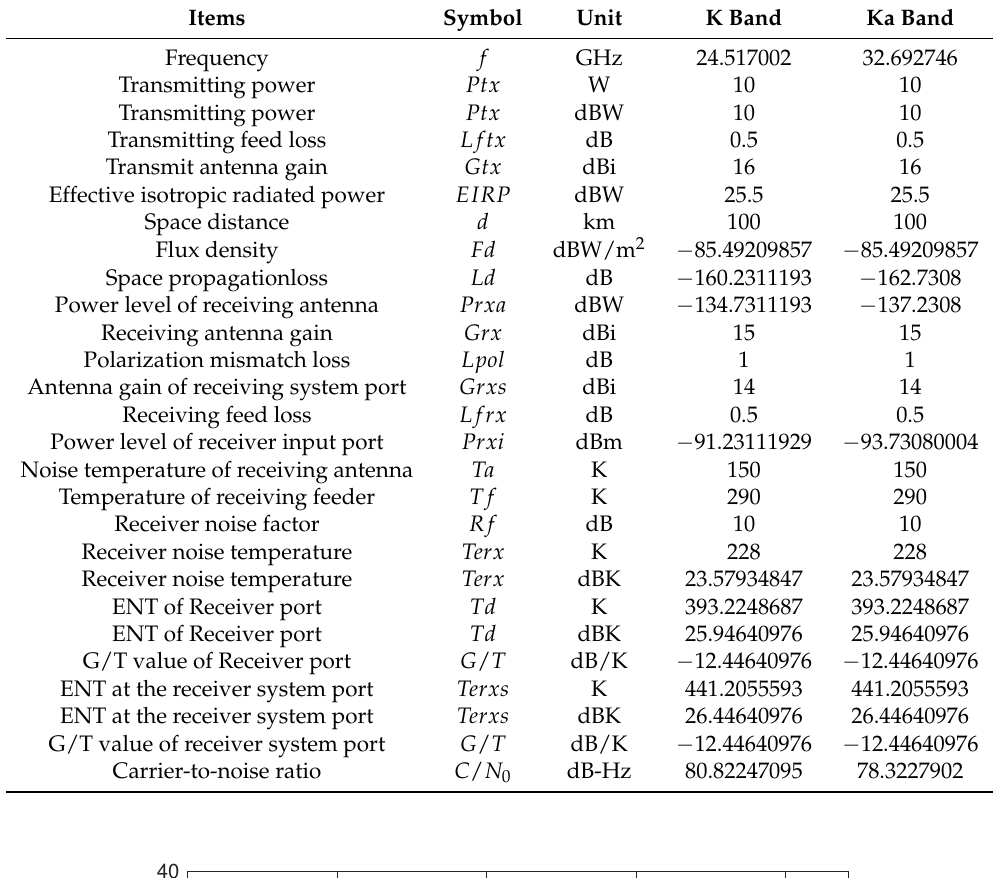
Table 3. Parameters of MWR ranging payloads.